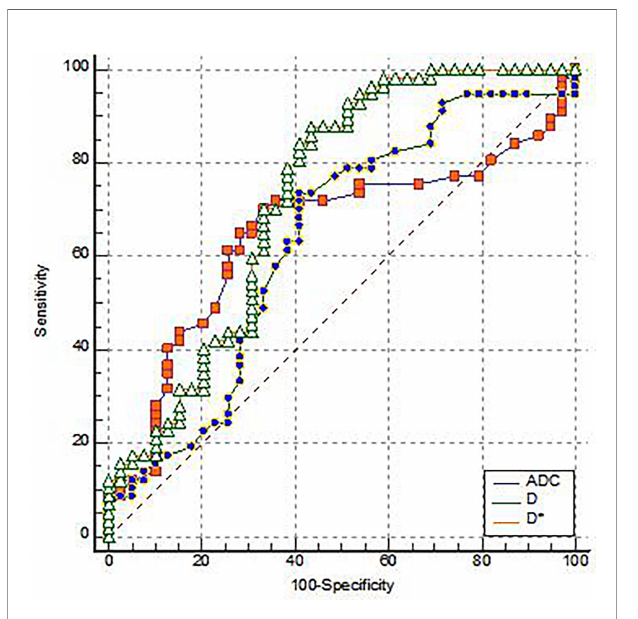
FIGURE 2 | The ROC analysis for the IVIM-DWI parameters of the EMVI positive group and the EMVI negative